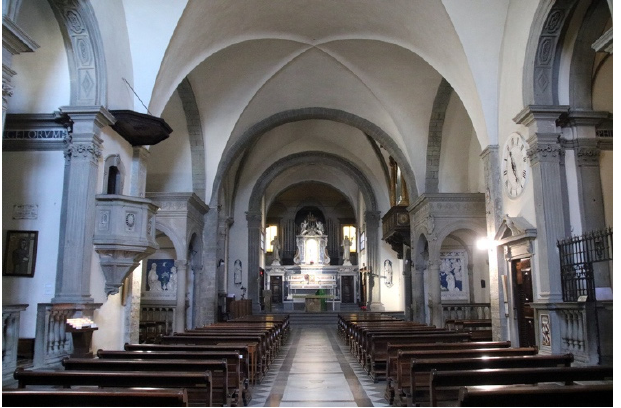
Figure 8. Exterior Chiesa Maggiore, La Verna (photo source: Mongolo1984, CC BY-SA 4.0, via Wikimedia Commons).